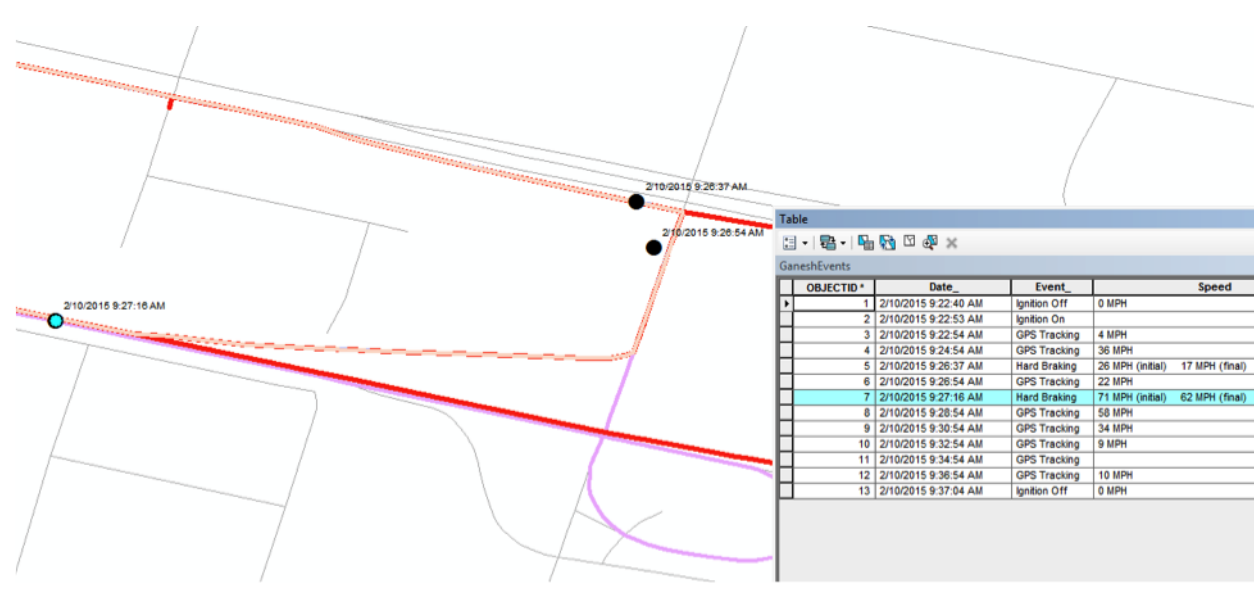
Figure 4. Incorrect